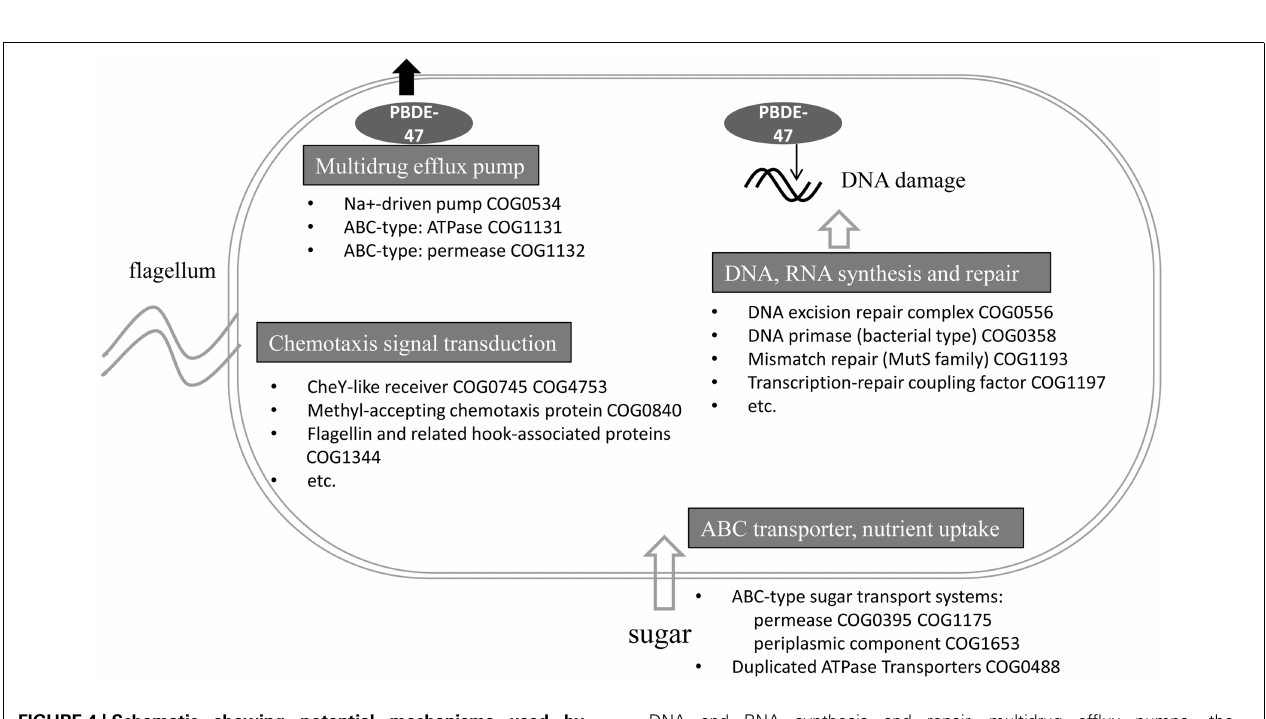
DNA and RNA synthesis and repair, multidrug efflux pumps, the ABC transporter, nutrient uptake and chemotaxis signal transduction are